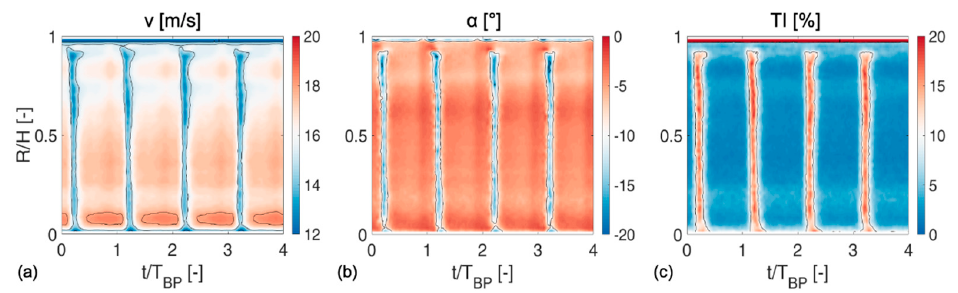
Figure 27. Time-resolved flow field quantities downstream of the rotating wake generator: velocity v ( a ), flow angle in circumferential direction α ( b ) and turbulence intensity TI ( c ) over channel height R/H for Sr = 1.33, φ = 0.97.